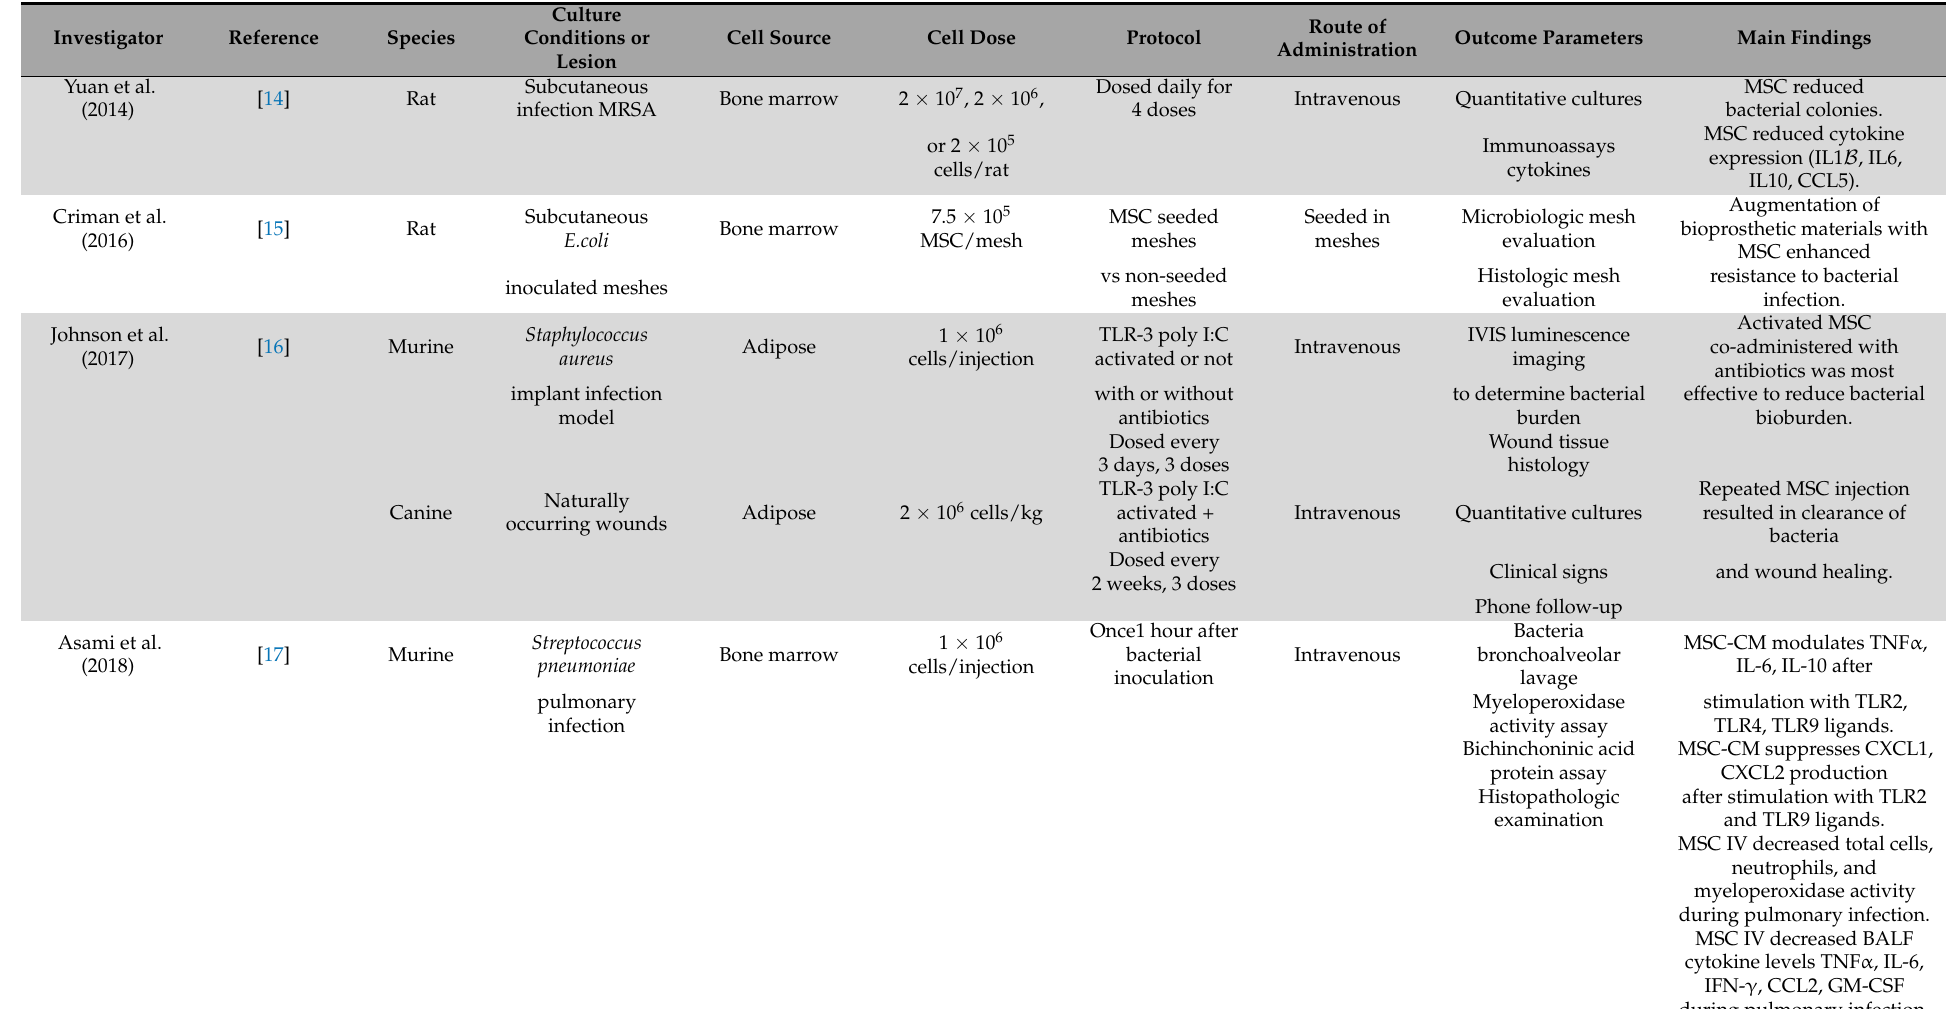
Table 1. Summary of studies demonstrating efficacy of (MSC) and conditioned medium (MSC-CM) in treatment of bacterial